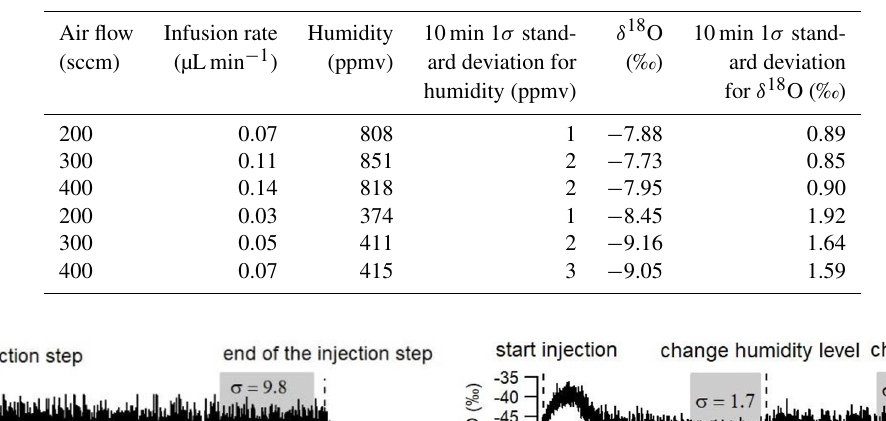
Table 2. Evolution and stability of humidity and δ 18 O (same water used for the different tests) for different syringe infusion rates and dry-air flows.